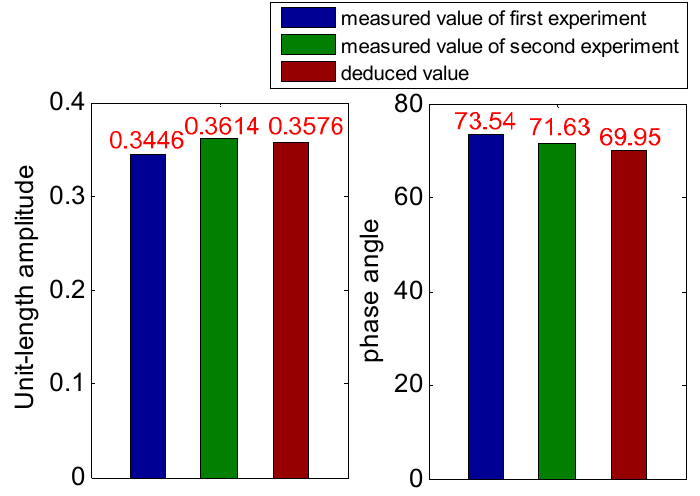
Figure 9. Comparison between measurement results and results of deduction for the integrated impedance.